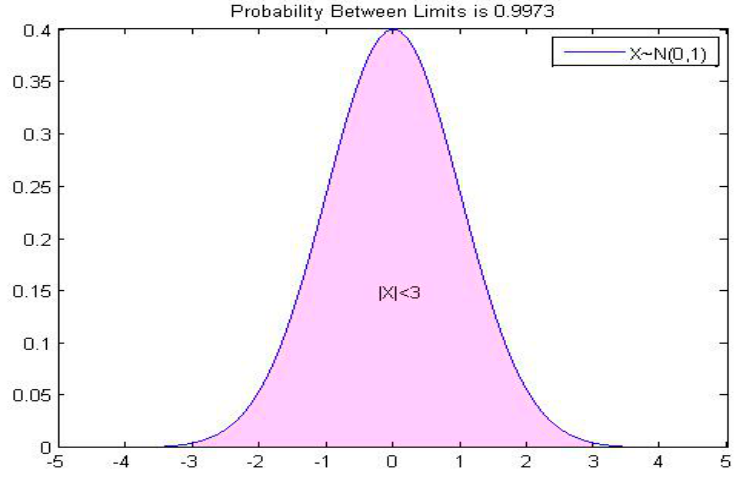
Figure 3. The ‘3 σ ’ law of the standard normal Figure 3. The ‘ 3  ’ law of the standard normal distribution.